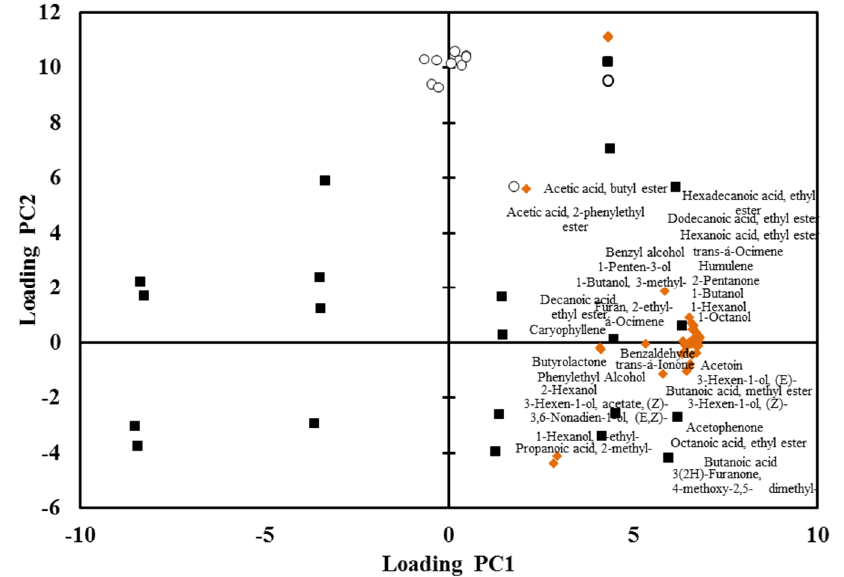
fruits (0, 2, 4, 6, and 8 days of ripening). Volatile compounds ( ); unknown compounds ( ); ripen- ing stages ( ).